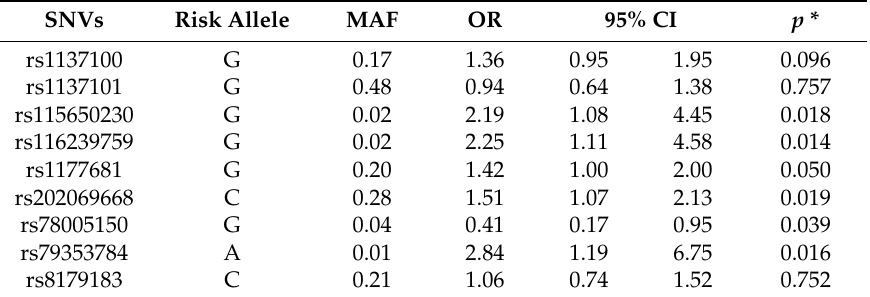
Table 3. Logistic regression between variants of LEPR and excess weight. Salvador, Bahia, Brazil,